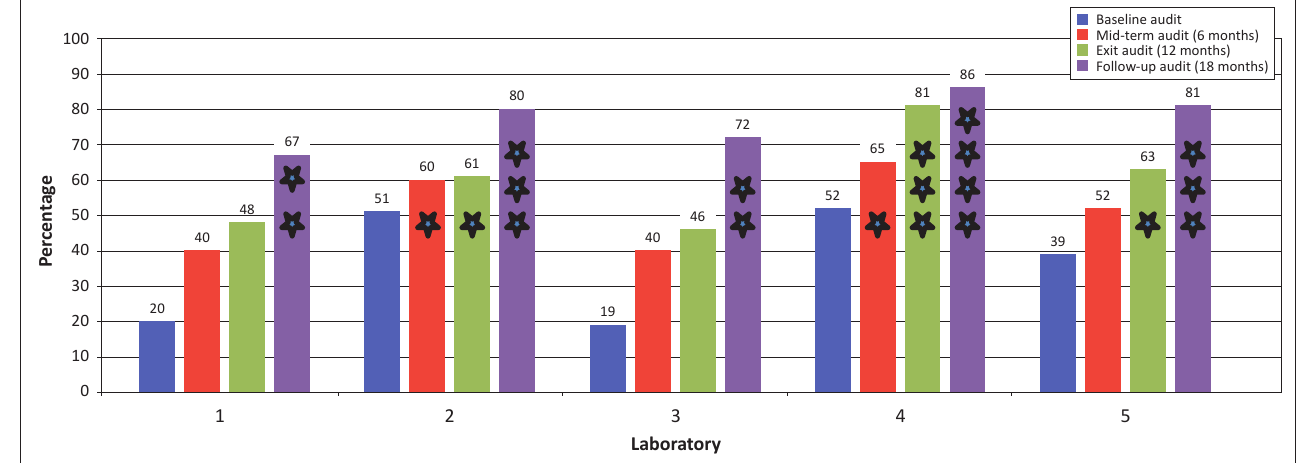
FIGURE 2: Improvement in implementation of the laboratory quality systems and stars attained over 18 months.